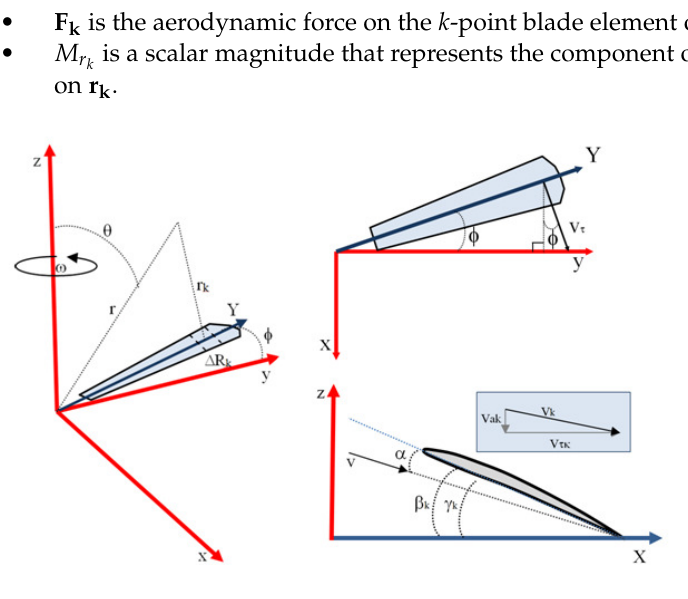
Figure 2. Representation of the reference coordinate system considered for the definition of the aeroacoustic